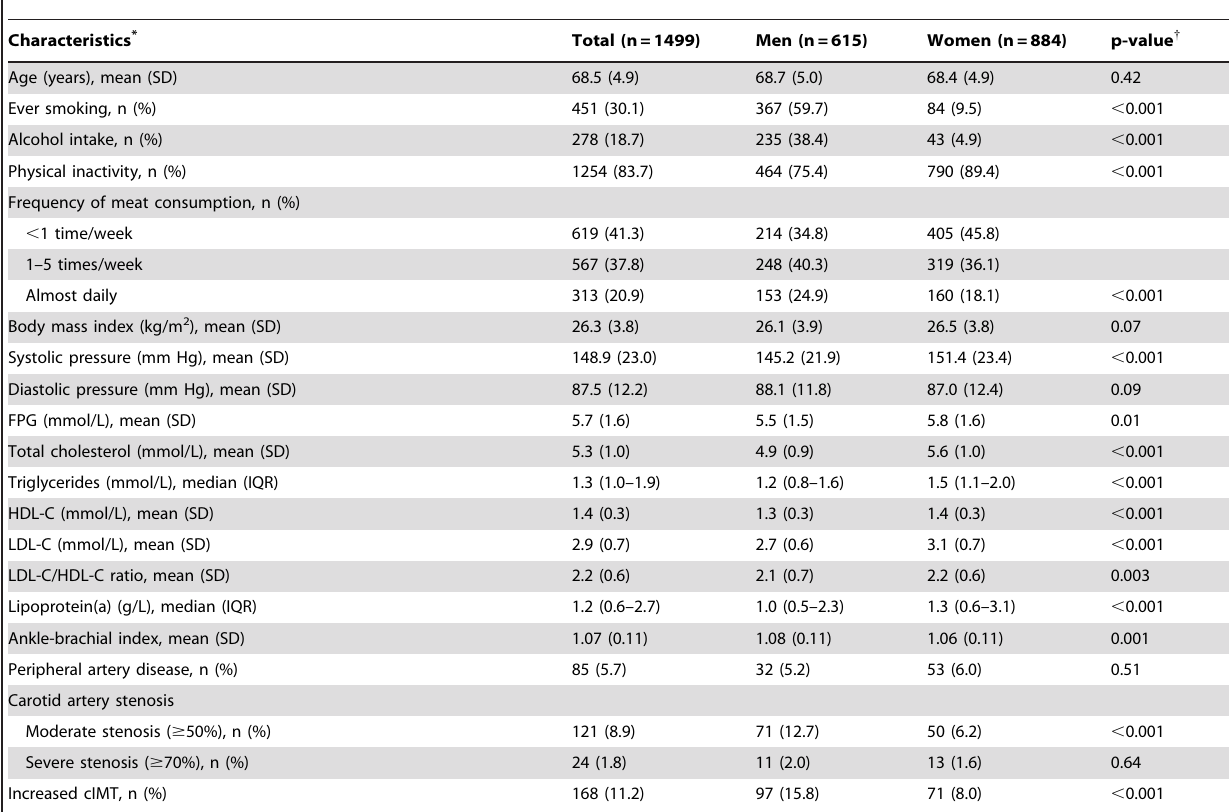
Table 1. Characteristics of study participants by